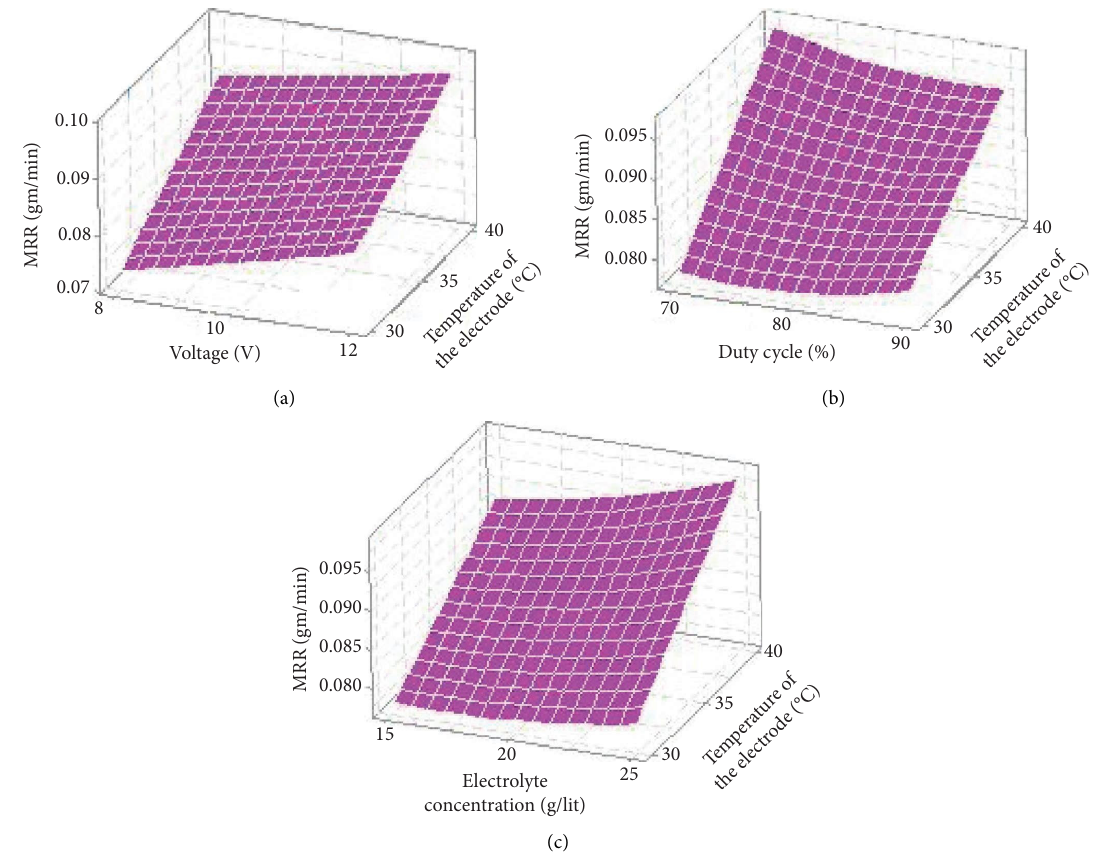
Figure 3: Process parameters efect on